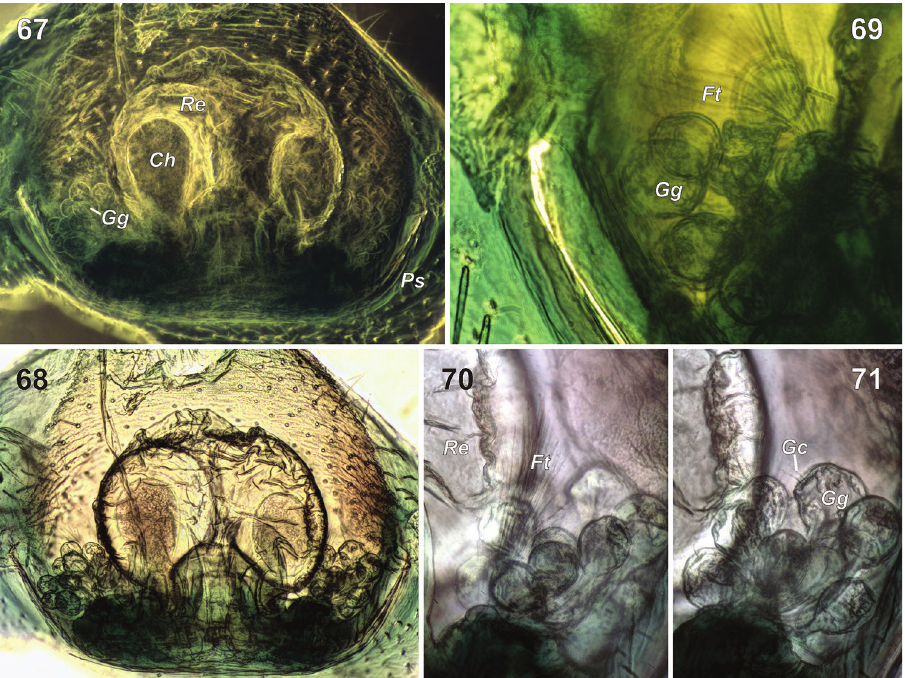
Figures 67–71. Female copulatory organs of Chedimanops eskovi sp. n. 67–68 vulva, dorsal 69 details of vulval structures, dorsal 70–71 details of vulval structures same spot but focused on fine threads ( Ft ) and glandular cilia ( Gc ) respectively. Other abbreviations: Ch receptacular chamber; Gg grape-shaped glands; Ps postgastral scutum; Re